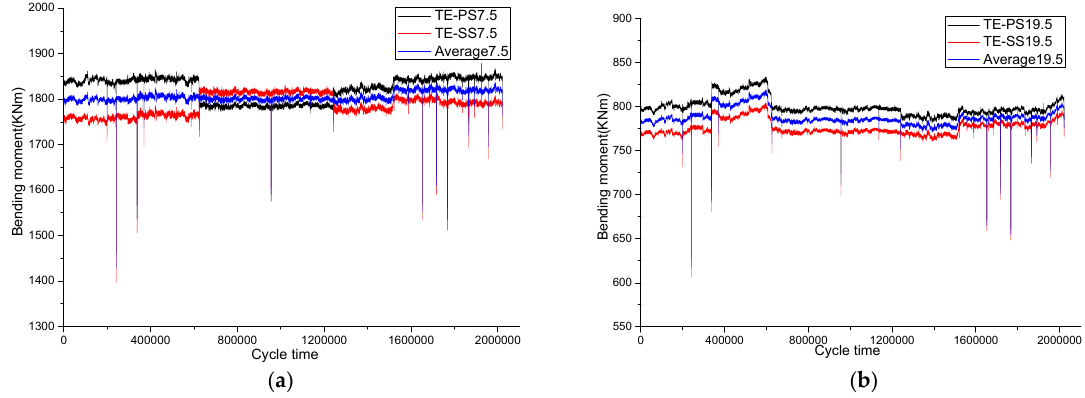
Figure 13. Two million cycle bending moment distribution. ( a ) Two million cycle bending moment distribution of section 7.5 m; ( b ) Two million cycle bending moment distribution of section 19.5 m.